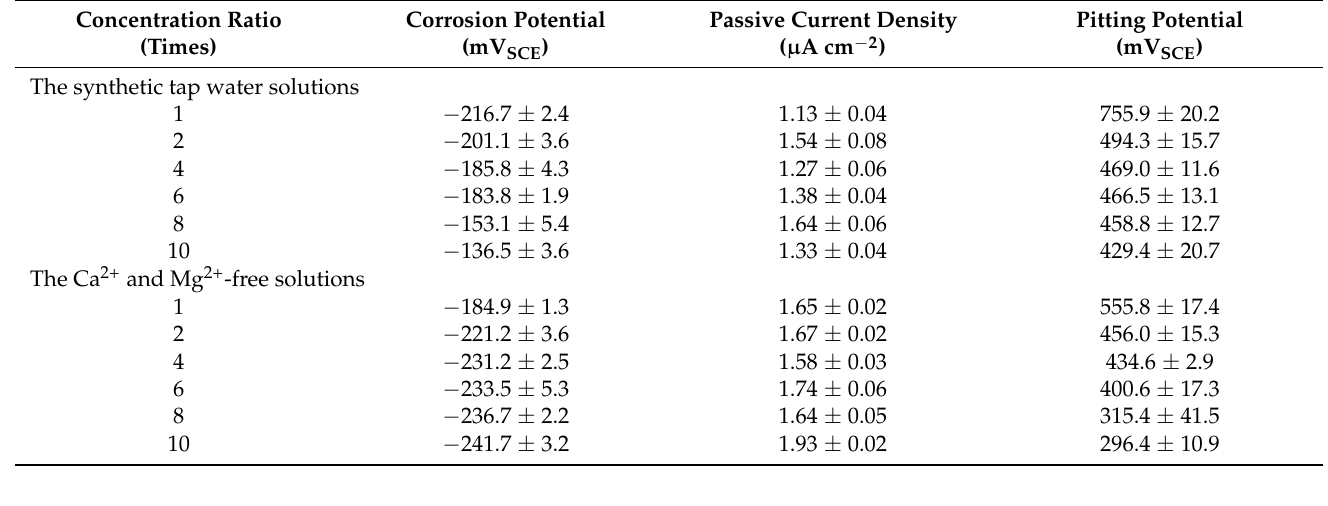
Table 3. Electrochemical parameters for 310S stainless steel in the two solutions.